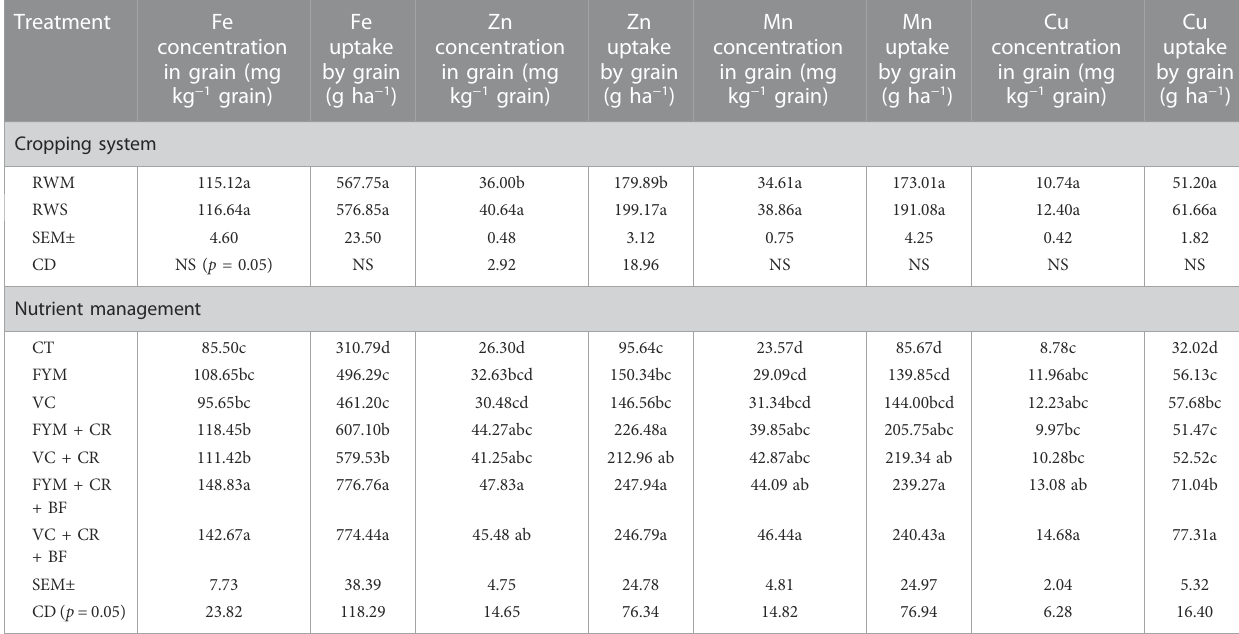
TABLE 4 Long-term effect of cropping systems and organic nutrient management on yield attributes and yield of basmati rice.